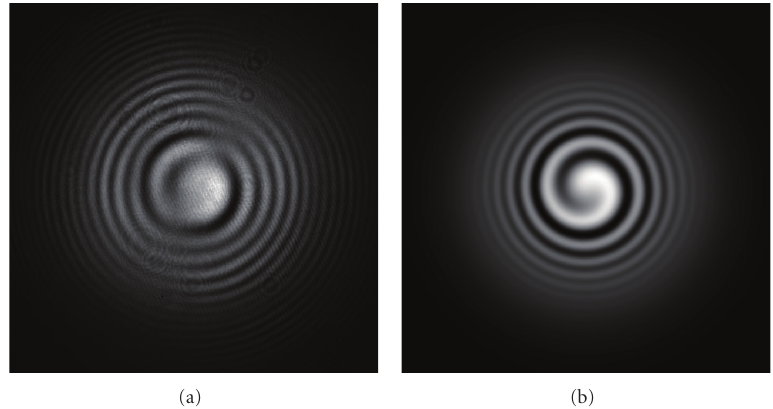
Figure 7: (a) Measured interference pattern between the beam generated for d = 50 μ m and a plane reference wave. (b) Calculated interference pattern between corresponding beams to